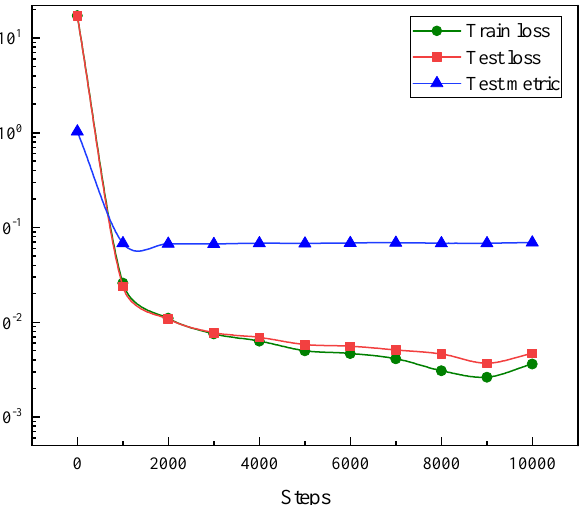
Figure 9. Mean squared error loss and test metric for two-dimensional consolidation model of drainage at a top